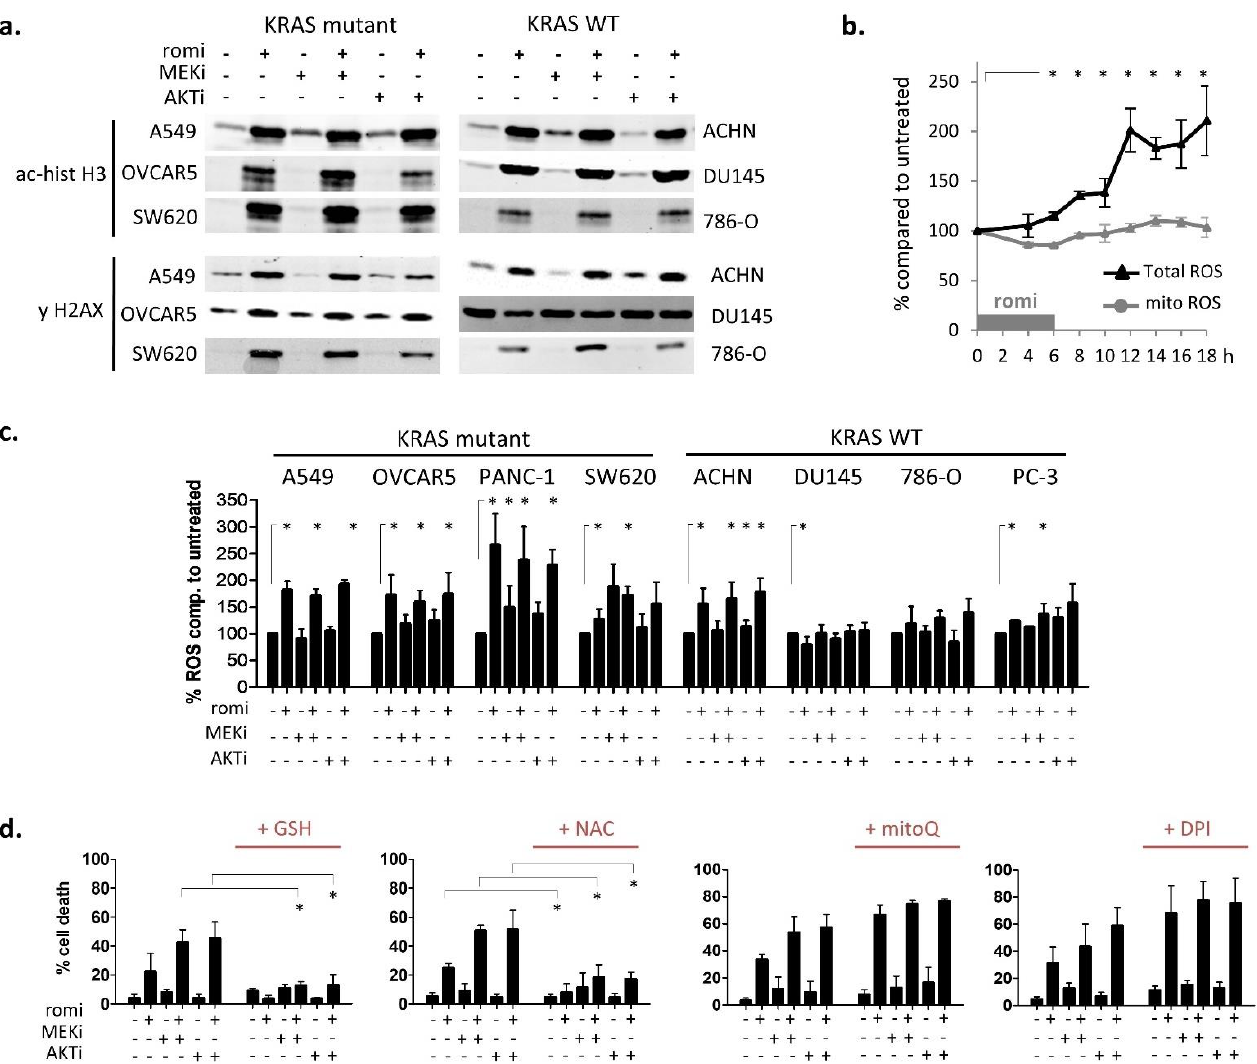
Figure 2. Early cytoplasmic ROS release differentiates KRAS sensitivity to romidepsin, while acetylation and DNA damage do not. ( a ) Histone acetylation and H2AX phosphorylation (DNA damage marker) were measured by WB in cells treated for 6 h with romidepsin ± MEKi or AKTi. ( b ) Total and mitochondrial ROS production were measured over time by flow cytometry for 18 h during treatment with romidepsin (clinical dosing) in A549 cell line. ( c ) Total ROS production was measured at 24 h in cell lines after romidepsin (clinical dosing) ± MEKi ± AKTi. ( d ) Percentage cell death was measured at 48 h in A549 cell line after treatment with romidepsin ± MEKi ± AKTi, in presence or not of cytoplasmic ROS scavengers (5 mM GSH or NAC), mitochondrial ROS scavenger (1 µ M MitoQ), or pan-NADPH oxidase inhibitor (5 µ M DPI). In ( b – d ), data are plotted as mean of three experiments ± SD, and statistical significance between groups was assessed using unpaired two-tailed Student’s t -test (* indicates a p -value <